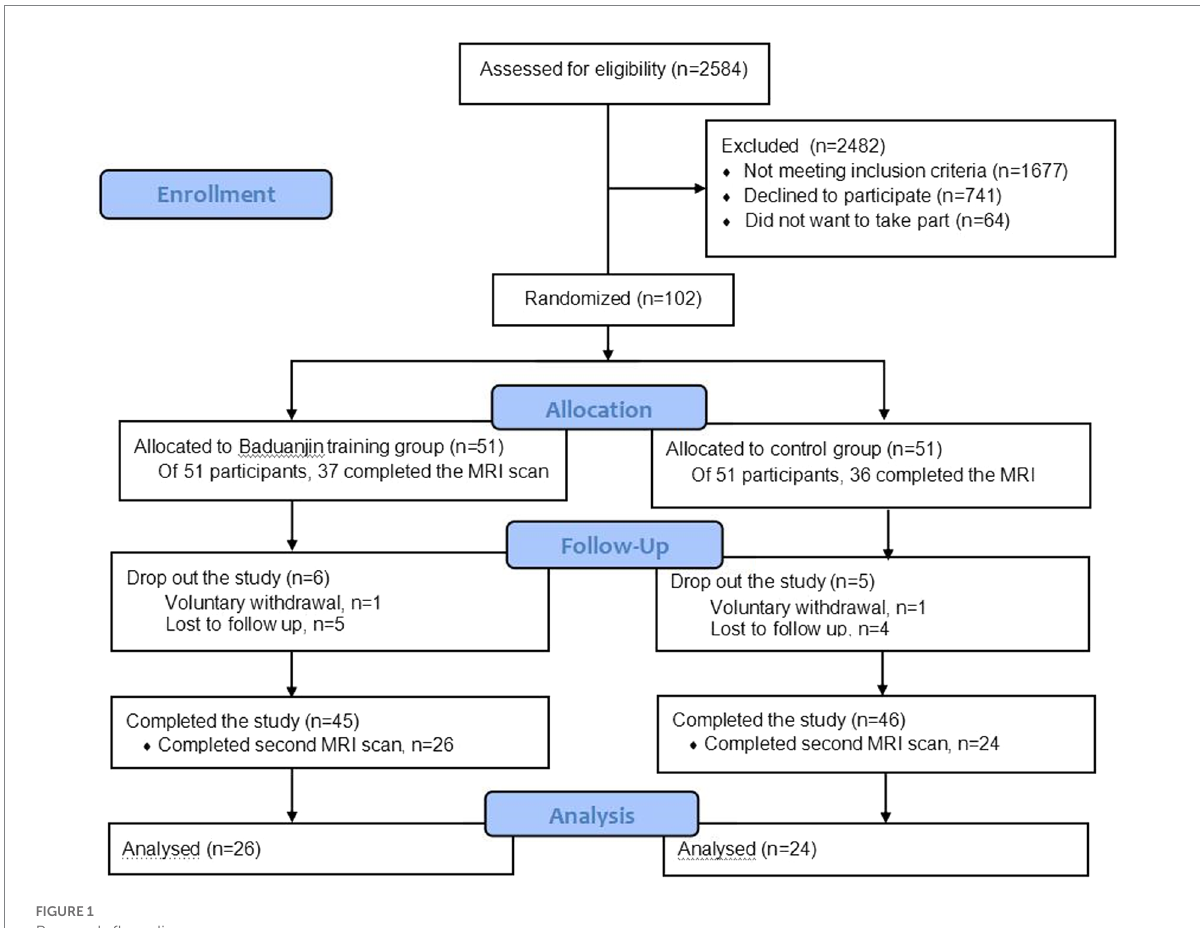
FIGURE 1 Research flow diagram.